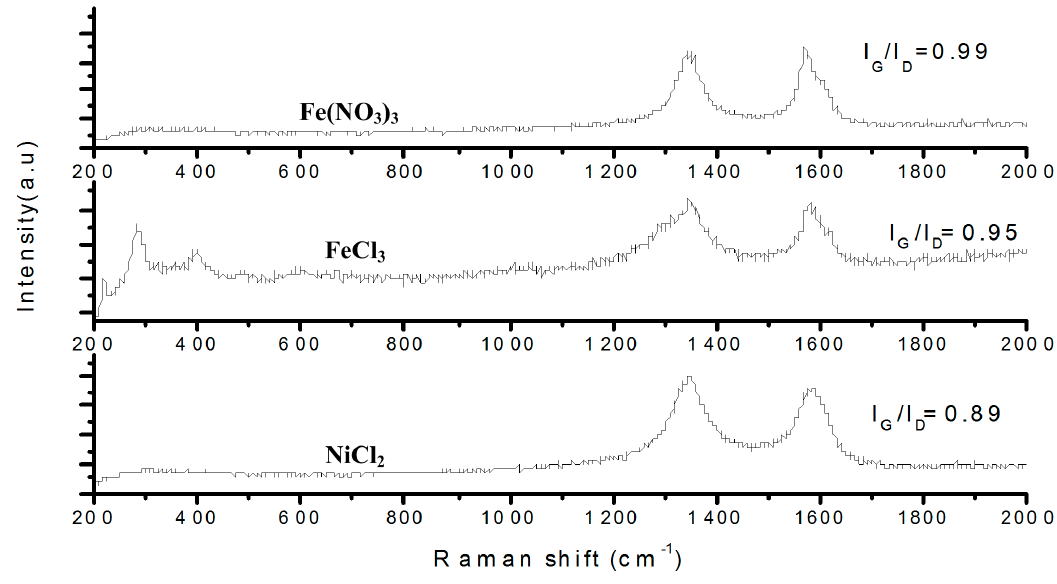
Figure 6. Raman analysis of CNT prepared with different catalysts.